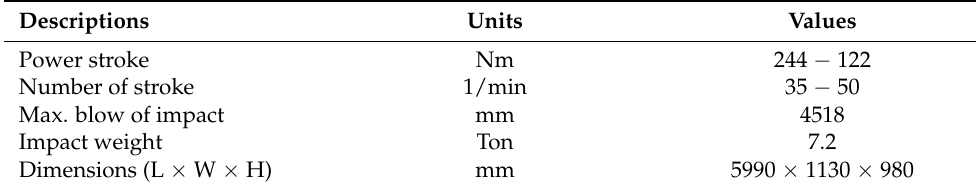
Figure 3. Pile Details: ( a ) Pile Head with Eight Pre-Stressed Cables and ( b ) Pile Tip. Table 2. Specifications of the Hammer (Model HD